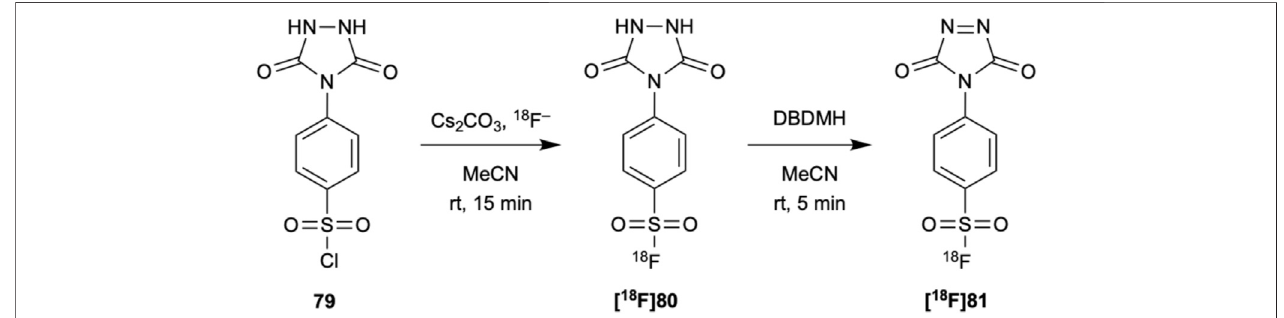
FIGURE12|[ 18 F]81 wassynthesized fromits correspondingsulfonyl chloride 79 using [ 18 F] fl uoride in acesiumcarbonate aqueous solutionfollowedbyoxidation with1,3-dibromo-5,5-dimethylhydantoin(DBDMH). [ 18 F]81 reactswithtyrosineunderbasic(pH9 – 10)conditionsatroomtemperatureandcouldbepotentiallyusedfor the indirect radiolabeling of proteins at this